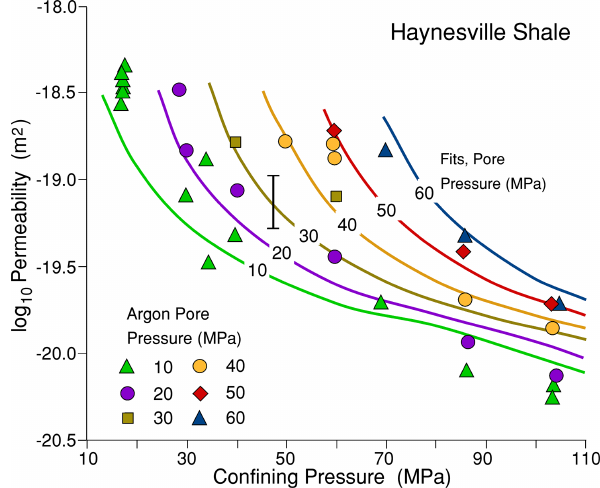
Figure 11. Permeability of Haynesville shale versus total confining pressure for various values of constant gas pore pressure. The curves shown are the permeabilities calculated using the elliptical section pore channel model (Eq. 19).